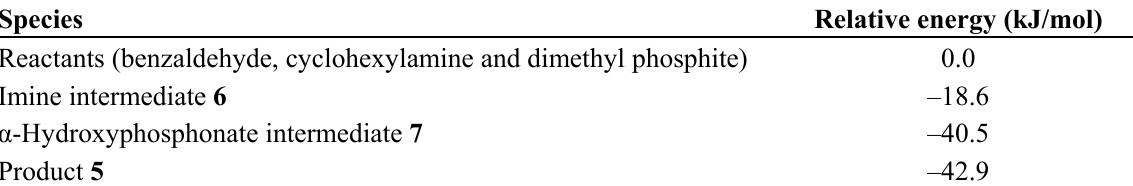
Table 1. Relative energies for the four states